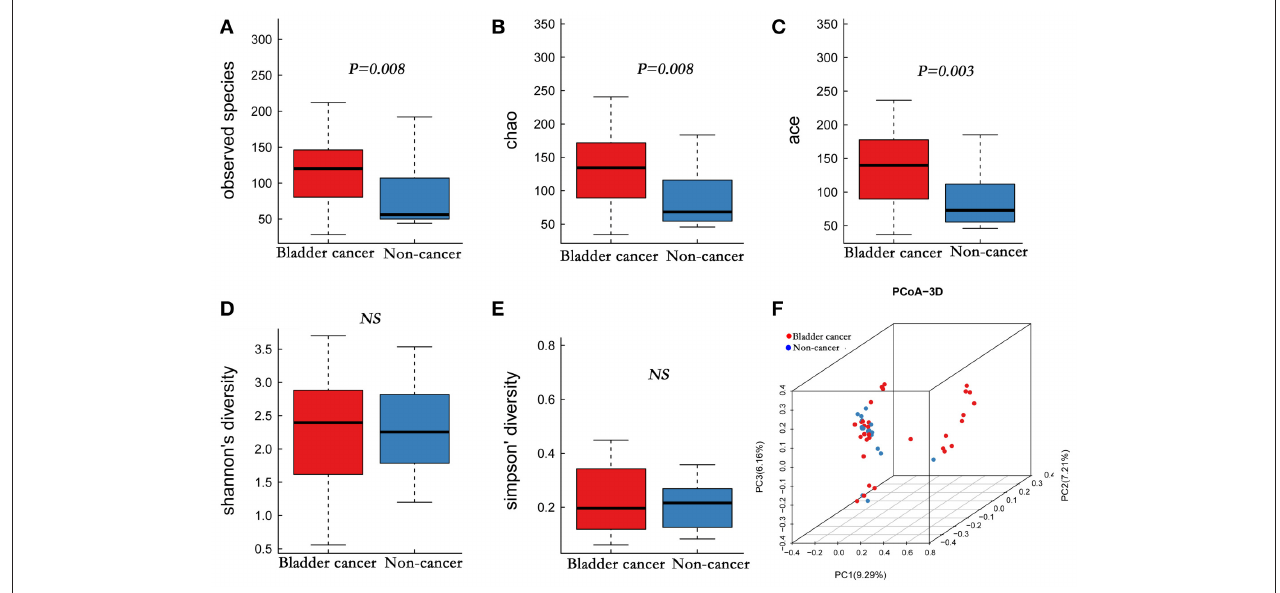
FIGURE 1 | Alpha and principal coordinate analysis (PCoA) for bladder-cancer samples and non-cancer samples. (A–E) Box-plot showing alpha diversity in samples using different metrics ( A, observed species index; B, Chao1 index; C, Ace index; D, Shannon index; E, Simpson index). (F) PCoA plots of unweighed UniFrac distances in which samples were colored by clinical outcome. The PERMANOVA performed on the unweighted UniFrac distances showed that the observed differences were statistically significant (999 permutations; F = 2.53; P <